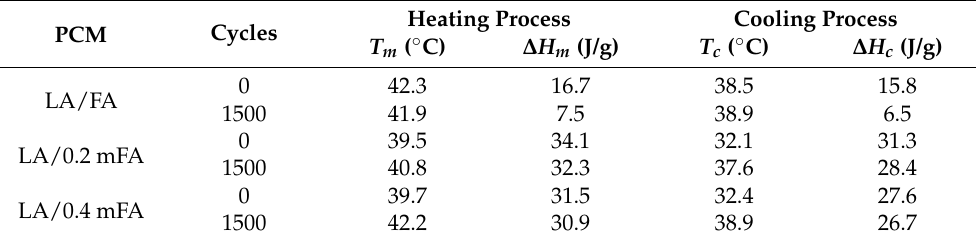
Figure 8. DSC curves of LA, LA/FA, LA/0.2 mFA, and LA/0.4 mFA: ( a ) before 1500 thermal cycles; ( b ) after 1500 thermal cycles. Table 3. Textural thermal properties of LA/FA, LA/0.2 mFA and LA/0.4 mFA before and after 1500 thermal